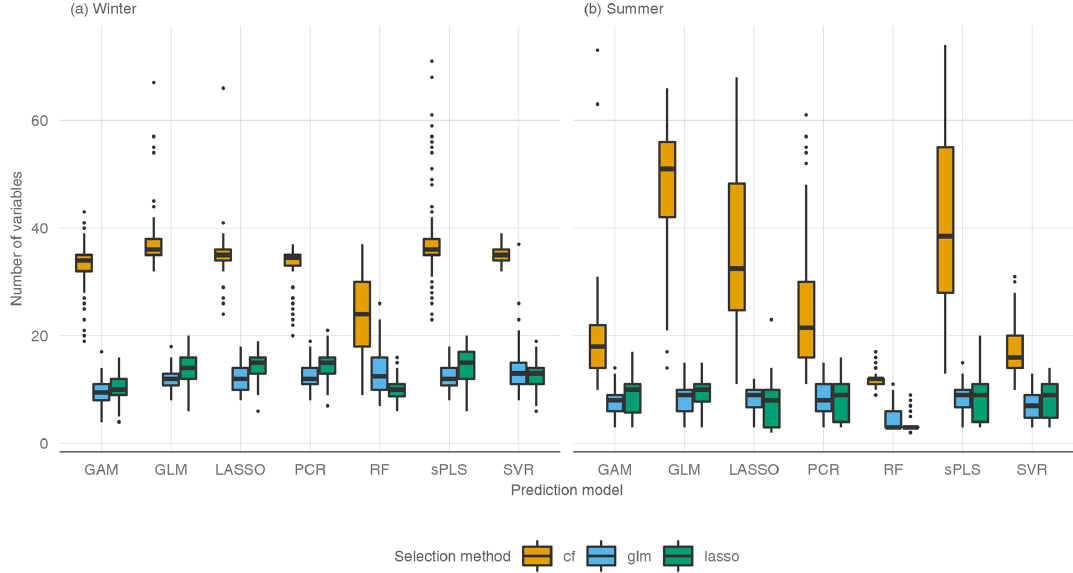
Figure A2. Box plots of the number of variables selected in each CV fold (100 times).